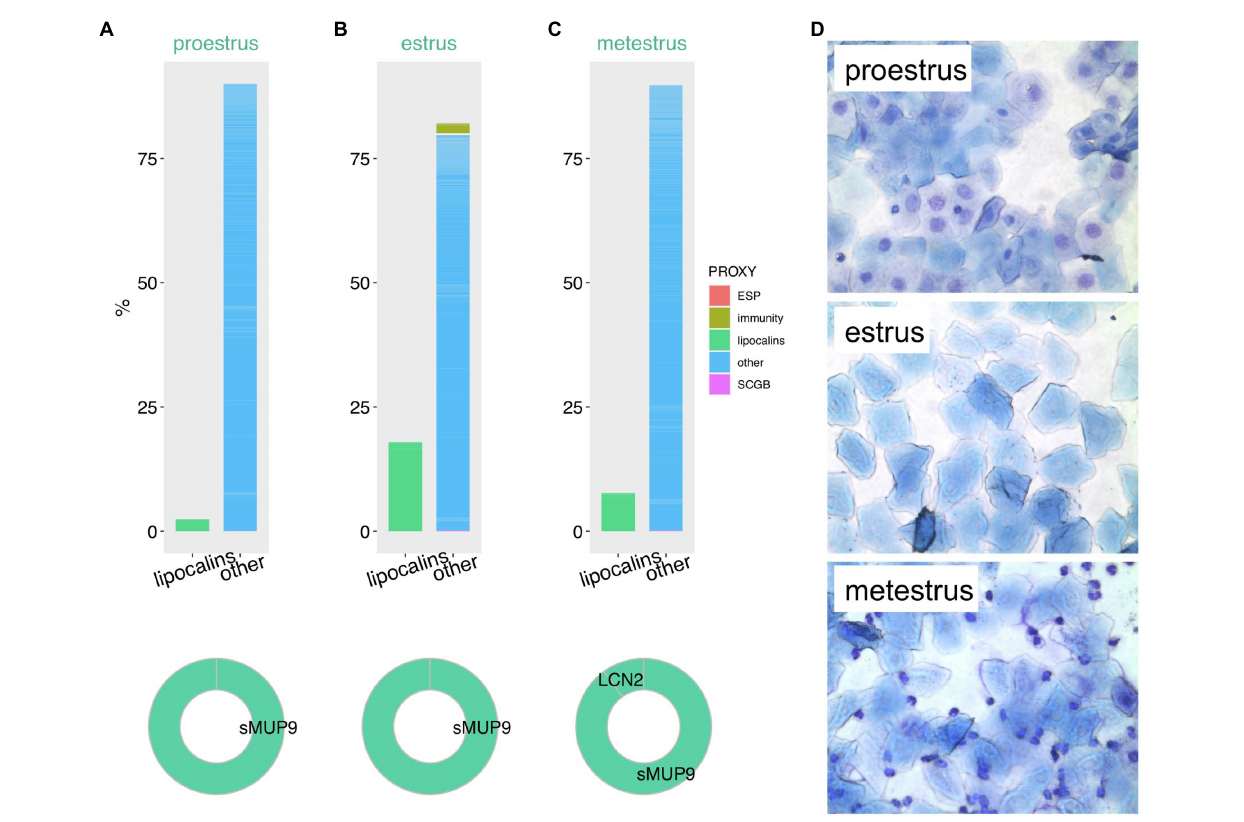
FIGURE 3 | Proteomic variation in vaginal secretions throughout the mouse estrous cycle. Estimation of protein abundances is represented as a fraction (%) of all proteins in vaginal lavages during proestrus (A) , estrus (B) , and metestrus (C) . We have extracted this data from our previously published study with publically available data. Proxy for functions (ESP, immunity, lipocalins, secretoglobins – SCGB) is based on public gene ontology tool. Representative microphotographs of the vaginal cytology were taken at magnification 100× after May-Gruendewald and Giemsa staining (D)